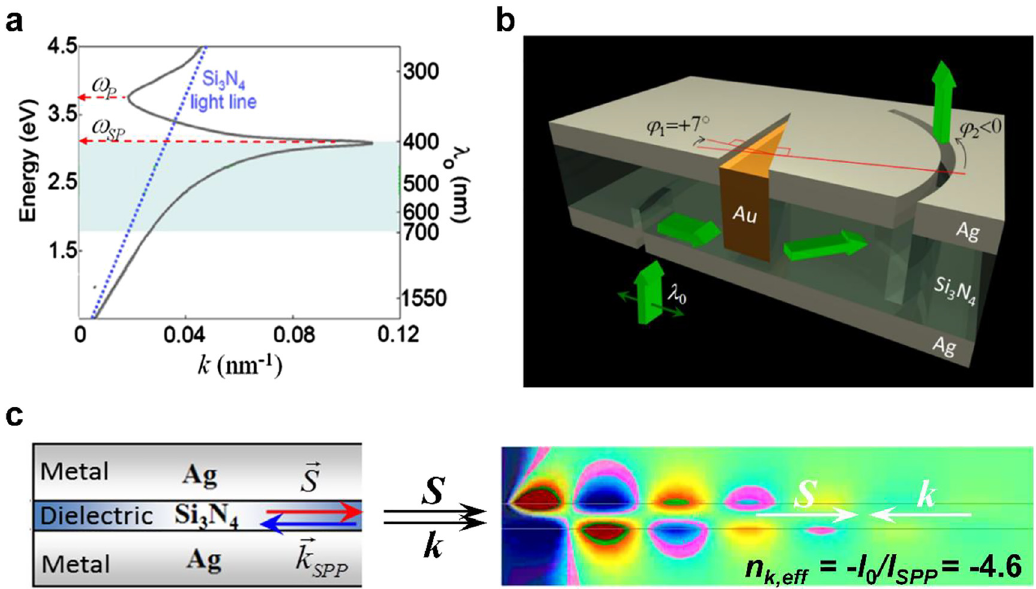
Figure3: (a)DispersiondiagramforaplasmonmodeinanMDMwaveguidecomposedofAg – Si 3 N 4 – Ag.Lezecetal.[51].©2007TheAmerican Association for the Advancement of Science. (b) Schematic drawing of negative refraction using Au-prism in an MDM waveguide. (c) FDTD-calculated magnetic fi eld distribution of the plasmon mode in an MDM waveguide when excited at normal incidence from free-space at λ 0 = 514